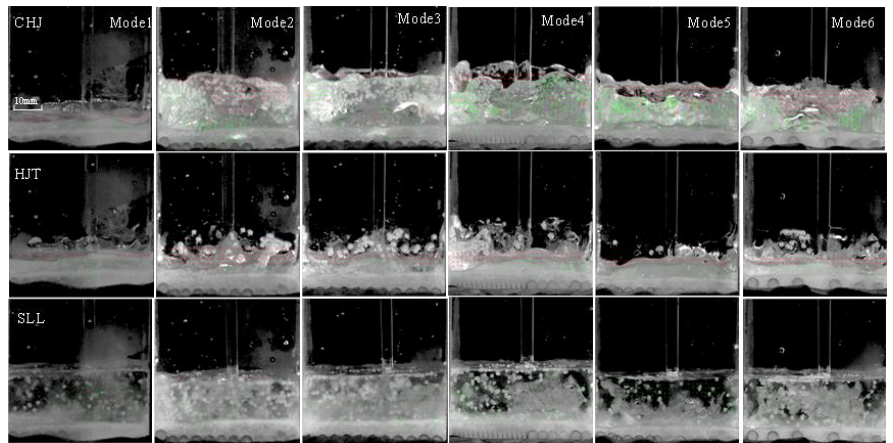
Figure 2. Hydraulic jump form and flow field in three physical forms of hydraulic jump of front view (casting speed of 0.8 m/min, mode 1 – 6).